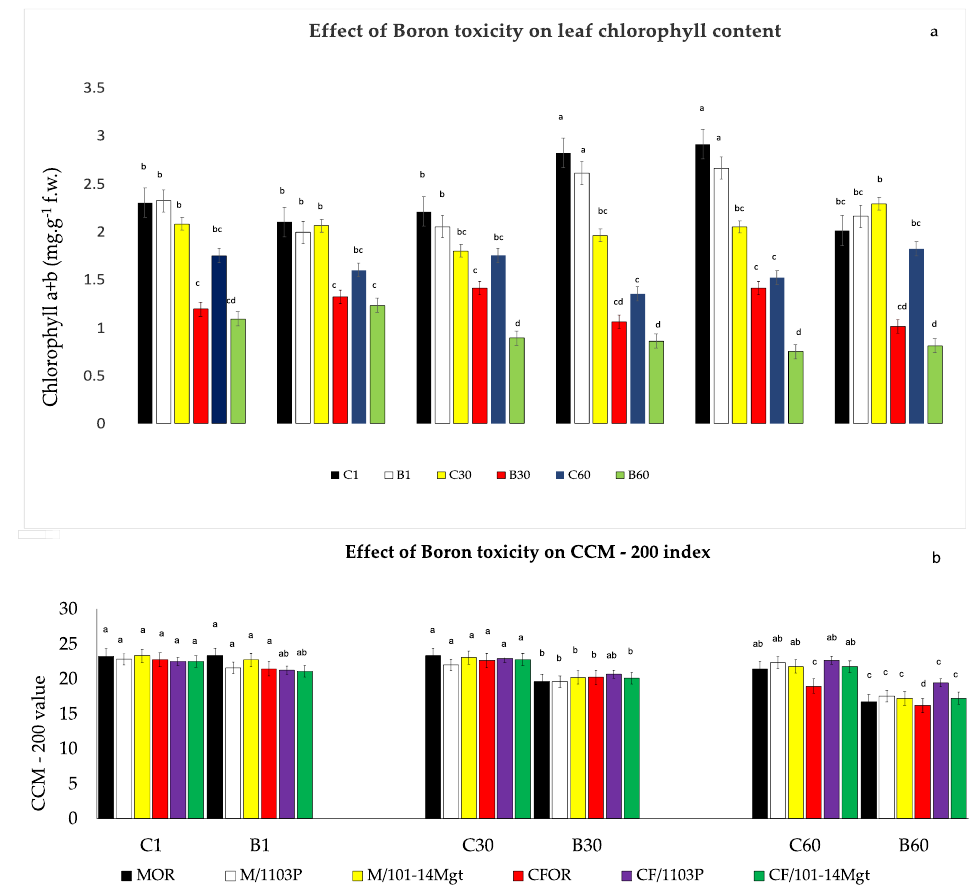
Figure 2. Leaf chlorophyll content ( a ) and CCM-200 Chlorophyll index ( b ) at the 1st, 30th and 60th day from the beginning of boron treatment of own-rooted (OR) or grafted onto 1103P and 101-14 Mgt, Merlot (M) and Cabernet Franc (CF) vine varieties. C represents the control treatment; B represents the boron treatment. Different letters represent significant differences at p < 0.05.